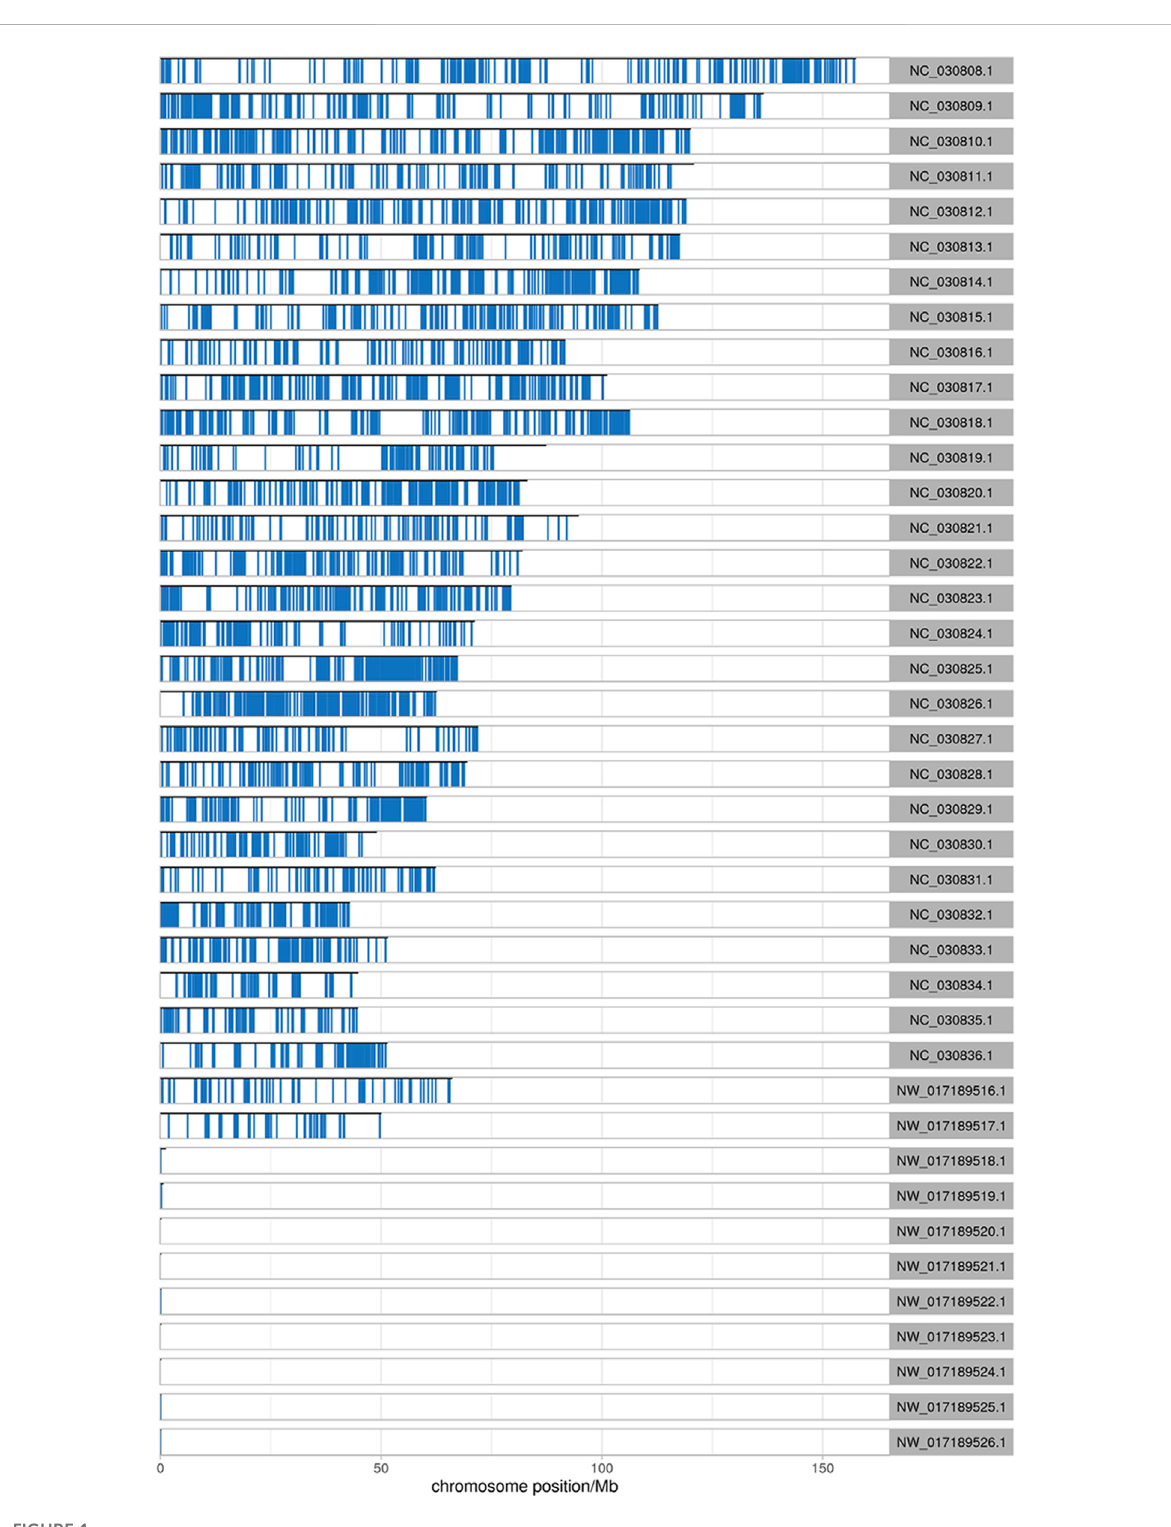
FIGURE 1 Distribution of reads on chromosomes. The abscissa is the chromosome locus (Mb), and the ordinate is the chromosome ID.